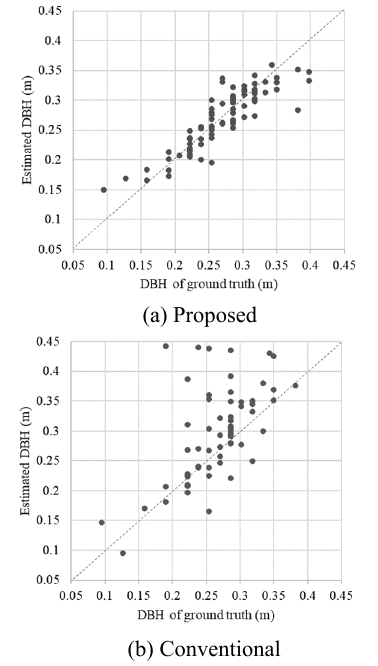
Figure 16 . Scatter plot of DBH